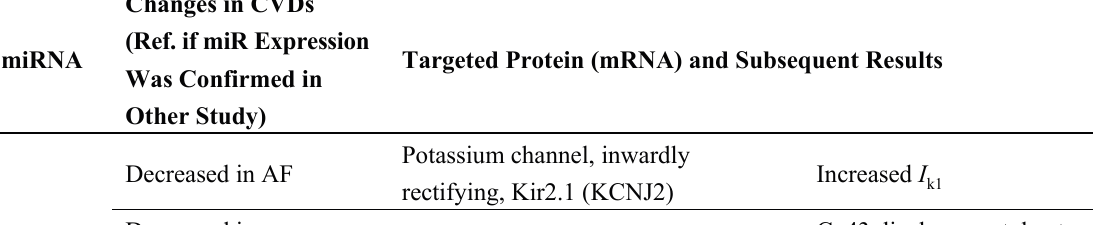
Table 1. miRNAs with reported or possible associations with atrial fibrillation